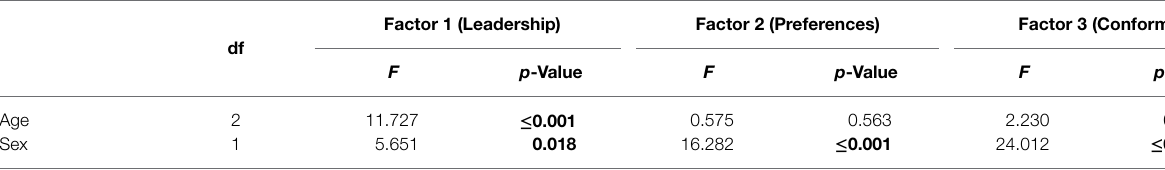
TABLE 3 | ANOVA of age group and sex on each of the three factors.